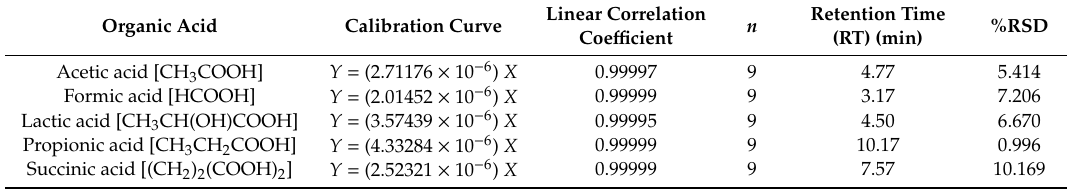
Table 3. Calibration curves of organic acids for the RP-HPLC-DAD analysis. Organic Acid Calibration